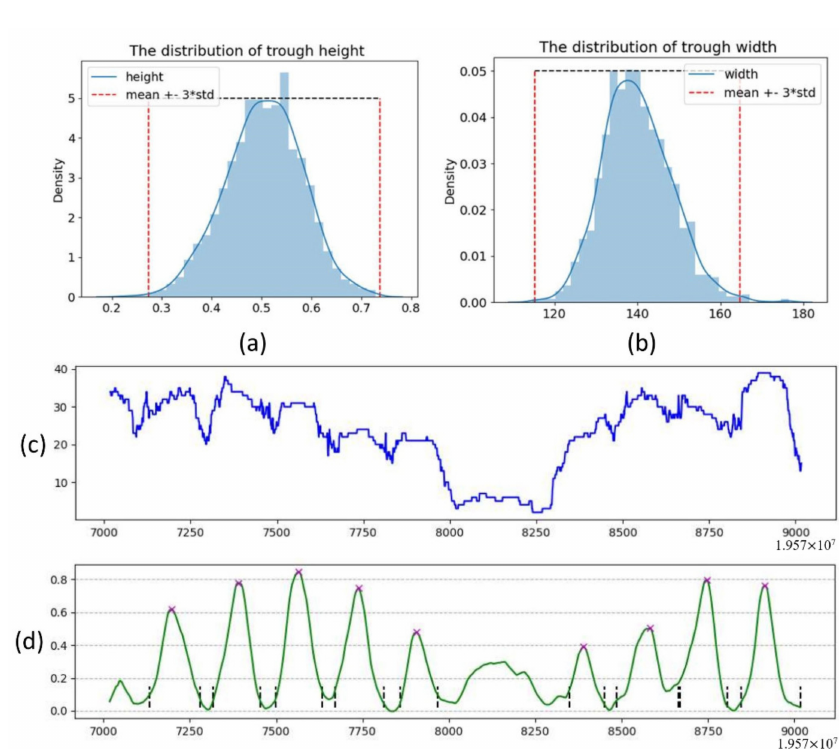
Figure 9. ( a , b ) The distribution of height and trough width, respectively. ( c ) The sequencing depth of the region. ( d ) The filtered WPS